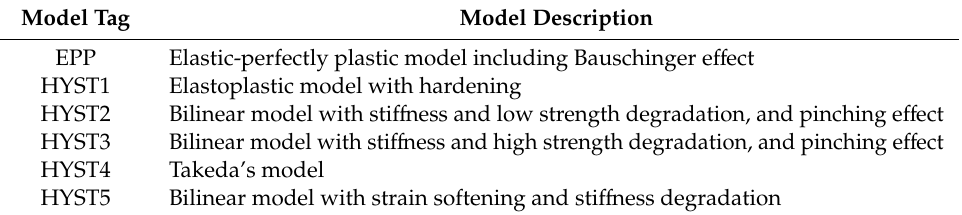
Table 1. Set of nonlinear constitutive laws under